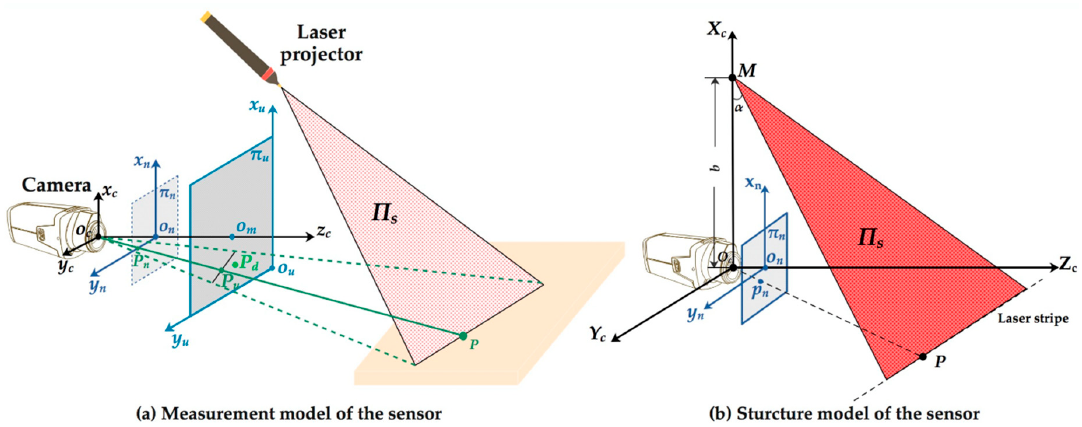
Figure 2. Measurement model and structure model of the structured-light sensor.